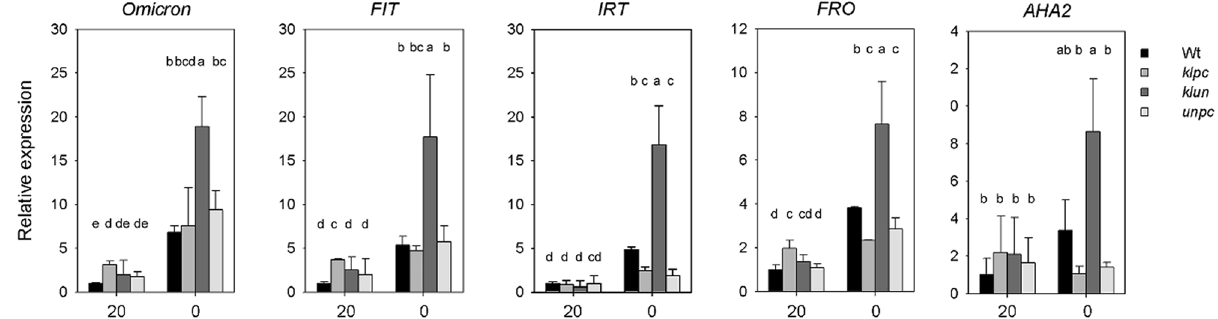
Figure 5. Expression analysis of 14-3-3 Omicron , FIT , FRO , IRT and AHA2 in Wt and 14-3-3 qKO lines grown with (plus) and without (minus) Fe. A. thaliana seedlings were grown in 1/2 strength Hoagland with 20 μM Fe-EDTA for 22 days and then transferred to medium with or without 20 μM Fe-EDTA for 24 h. Expression levels were normalized to ubiquitin 10 (UBQ10) and then to the value of each gene from the Wt under Fe-sufficient conditions. Values are means of three independent experiments and error bars represent ± SD (n = 3). Different letters above the column indicate that the values are significantly different at p < 0.05 according to Tukey’s